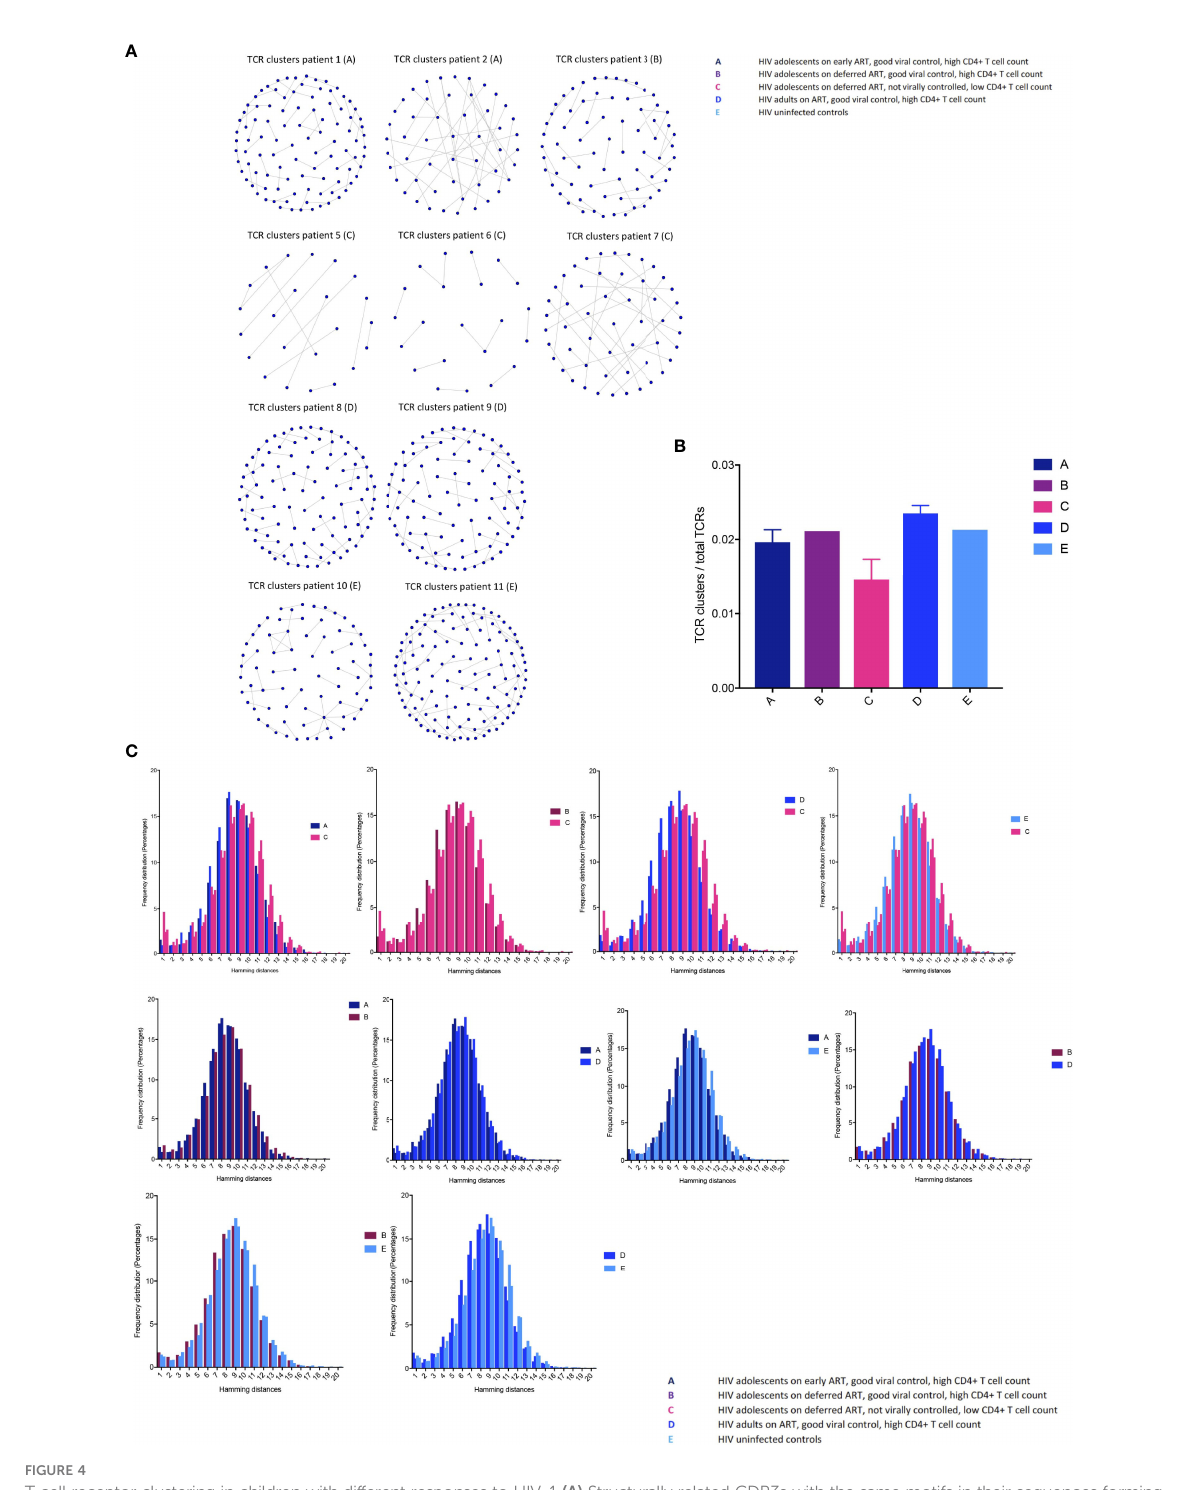
FIGURE 4 T cell receptor clustering in children with different responses to HIV-1 (A) Structurally related CDR3s with the same motifs in their sequences forming network clusters (shown as nodes) in the CD8 + T cell population. (B) TCR clusters (nodes) as a proportion of the number of total TCRs being clustered for each sample, showing median (IQR). (C) The distribution of pairwise Hamming distances between CDR3s in the CD8 + T cell